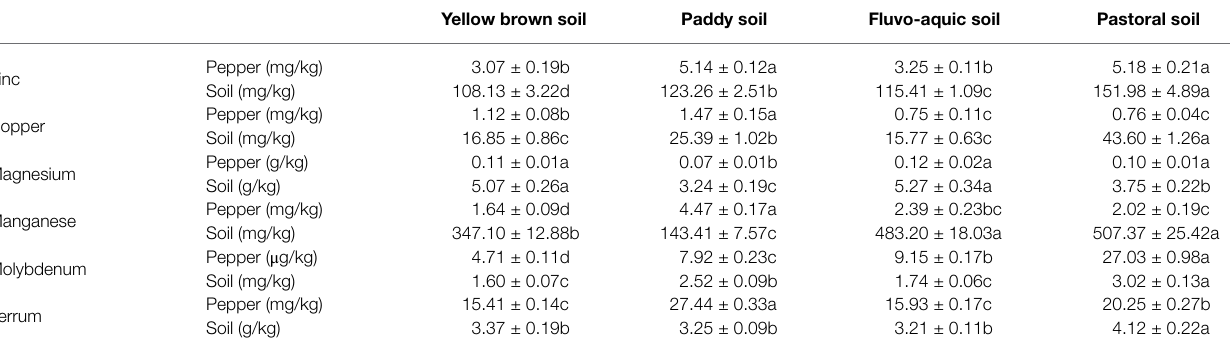
TABLE 3 | Effects of different soil trace elements on the absorption of trace elements in